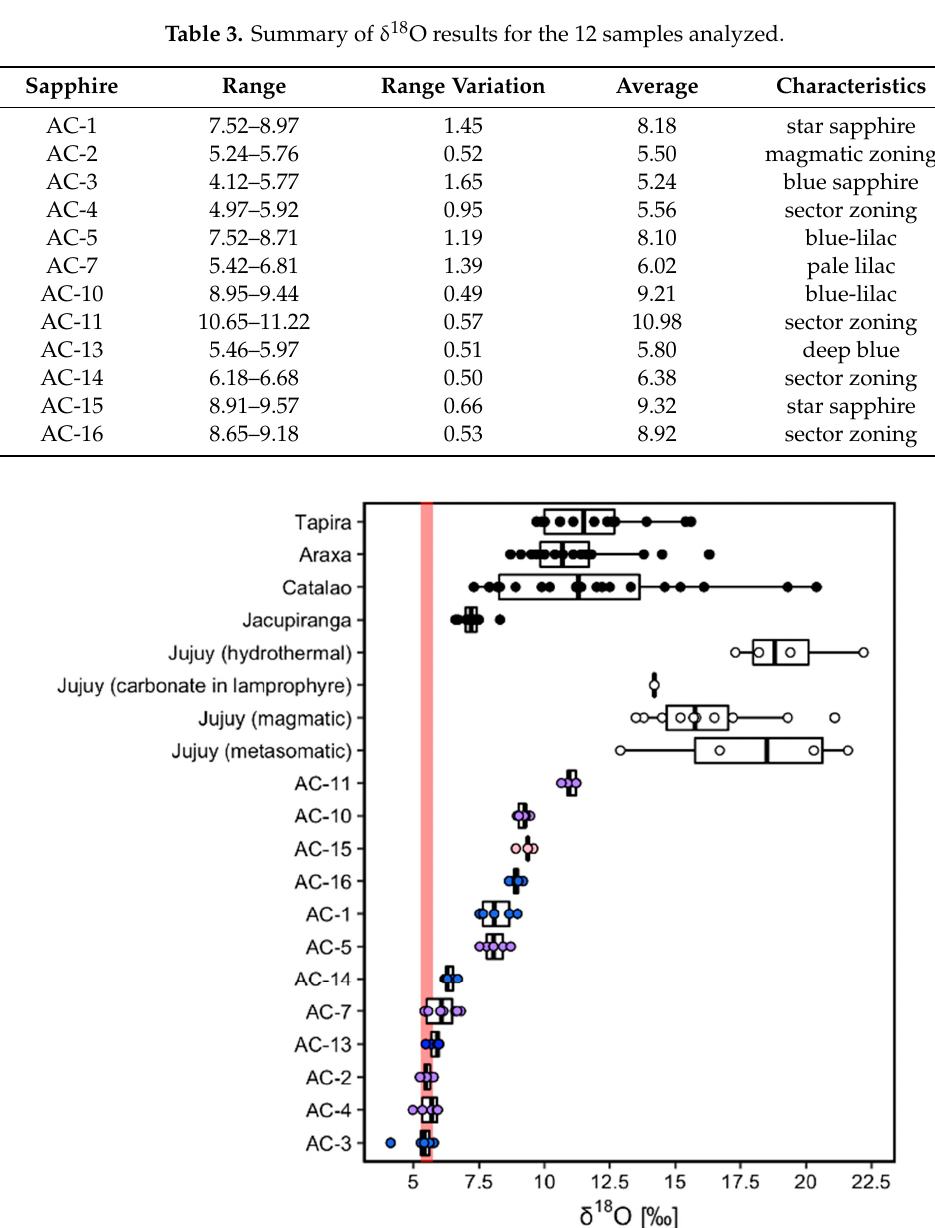
Figure 3. Diagram showing the range in oxygen isotope values for Jujuy sapphires (this study) in comparison to carbonatites and lamprophyres from the Jujuy region [17] and those of carbonatites from Brazil [18] and mantle δ 18 O value (red band).